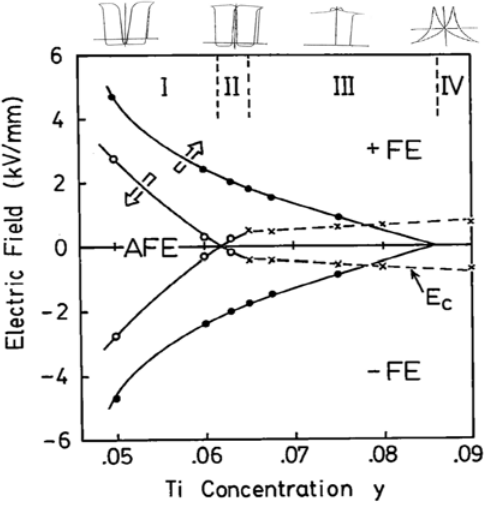
Figure 11. Phase diagram of Pb 0.99 Nb 0.02 [(Zr 0.6 Sn 0.4 ) 1-y Ti y ] 0.98 O 3 at room temperature with respect to the composition y and the applied electric field E.